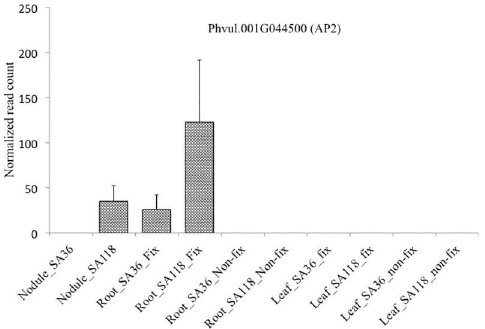
Fig 6. Relative expressionof Phvul . 001G044500 (AP2 transcription factor) in leaves, roots and nodules of SA36 and SA118 grown under nitrogen fixing and non-fixing conditions. Relativegene expressionis presentedusing read count. Read count is number of reads (averageof three replications) alignedto the gene after normalizing for total number of reads mapped for each library using